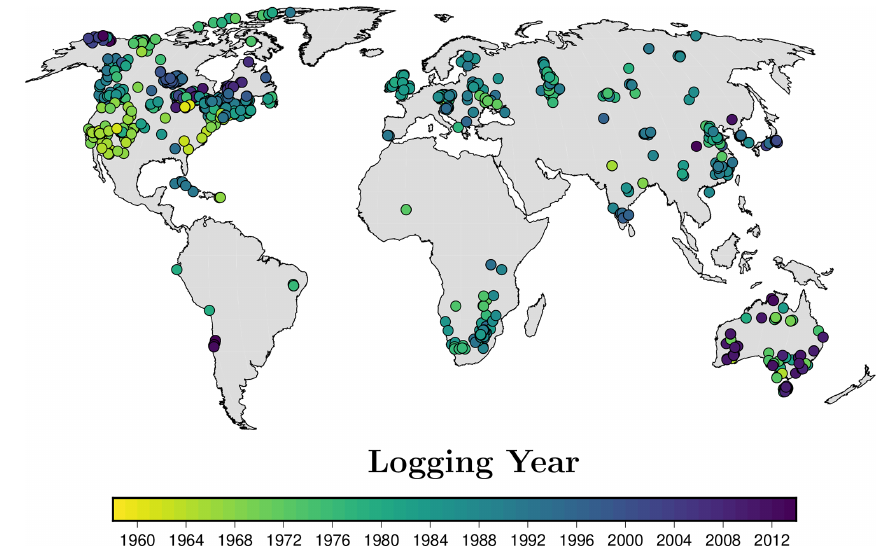
Figure 1. Logging years of the 1079 boreholes considered in the analysis.